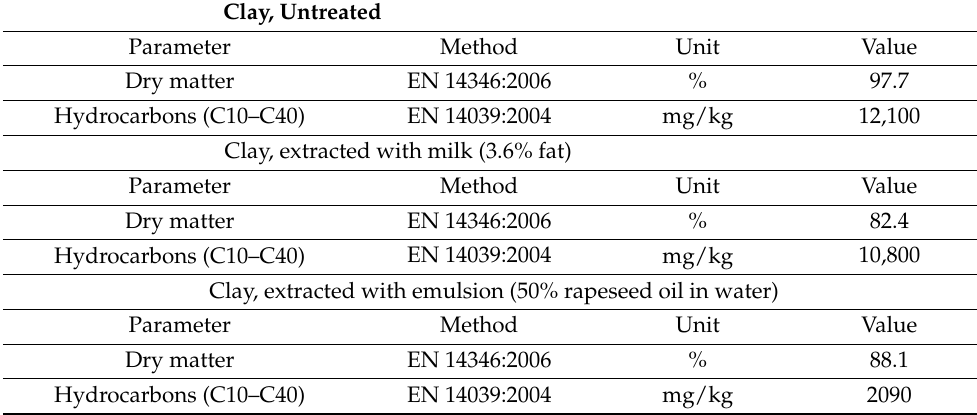
Table 4. Extraction experiments with clay from